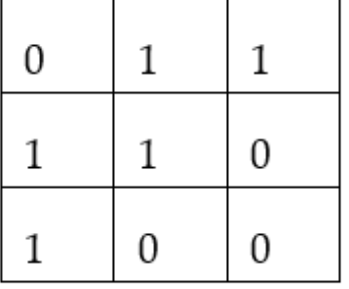
Figure 8. 8-neighborhood of P1. Table 1. Binary codes corresponding to the eight neighbors of Table 1. Binary codes corresponding to the eight neighbors of P1.